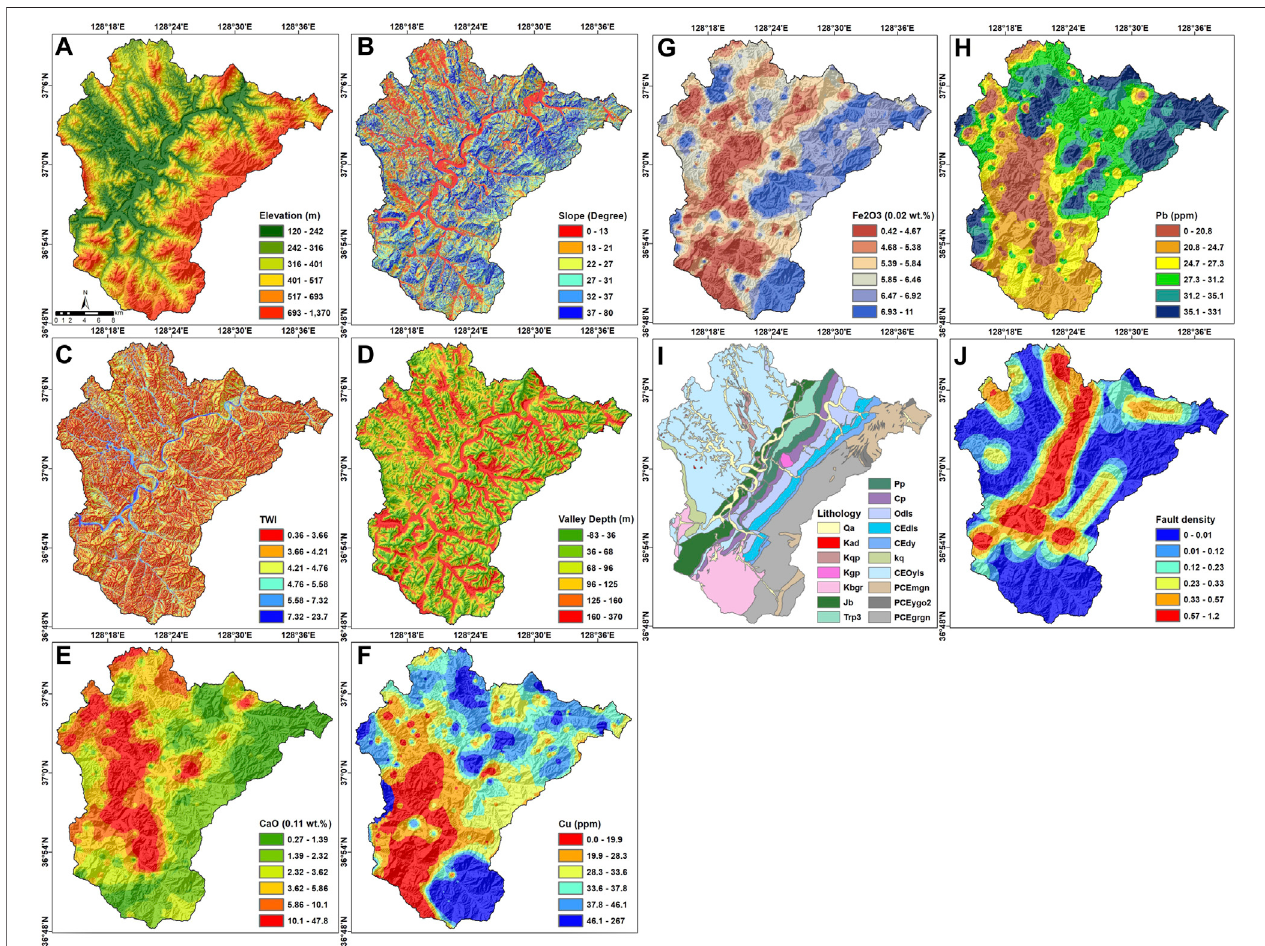
FIGURE 3 | Indoor radon maps: (A) elevation, (B) slope, (C) TWI, (D) valley depth, (E) mean soil CaO concentration, (F) mean soil Cu concentration, (G) mean soil Fe 2 O 3 concentration, (H) mean soil Pb concentration, (I) lithology, and (J) fault